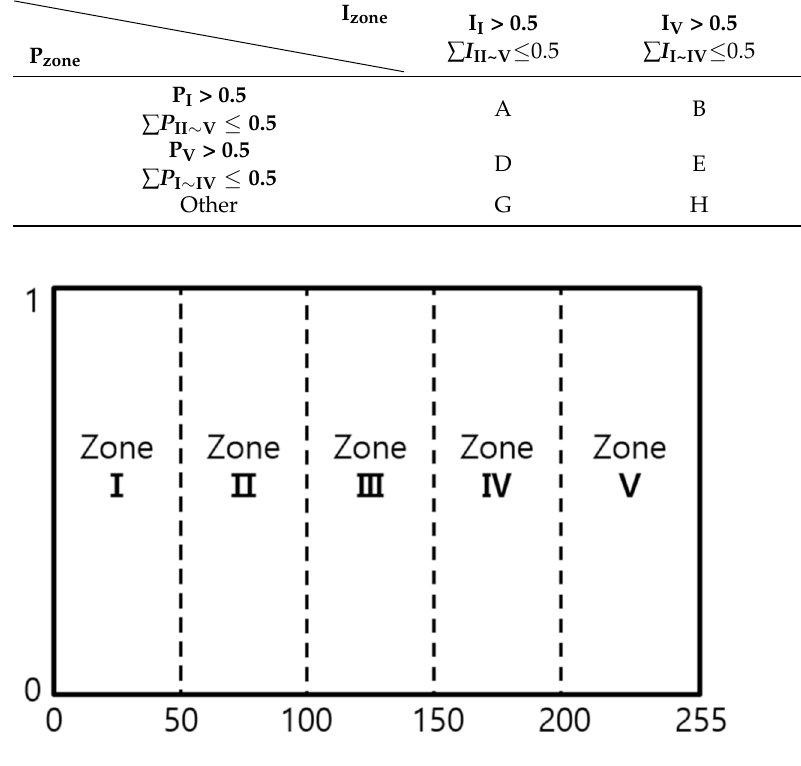
Figure 5. Definition of Zone in the normalized histogram of